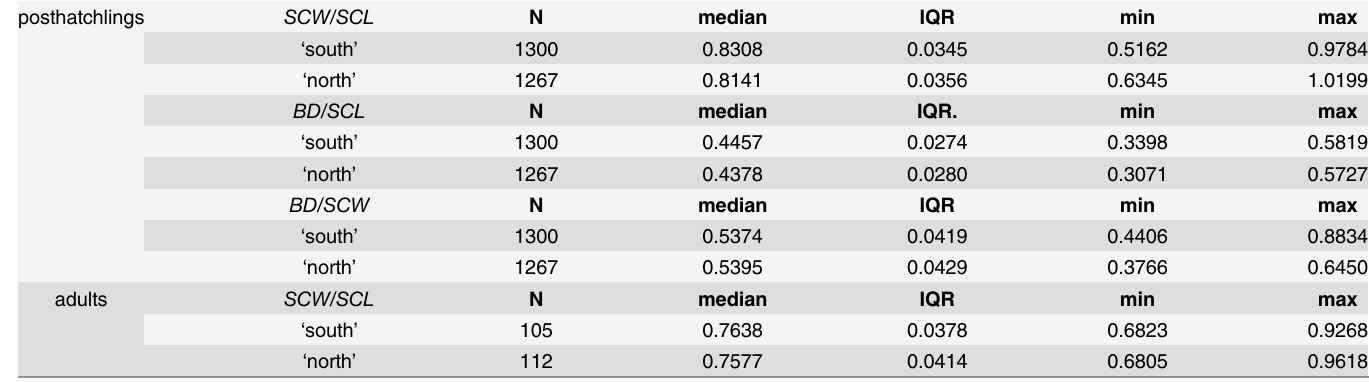
Table 2. Descriptive statistics. number of data points ( N ), median, interquartile range (IQR), minimum, and maximum of ratios, for posthatchlings and adults of regional subsets ‘ north ’ and ‘ south ’ .